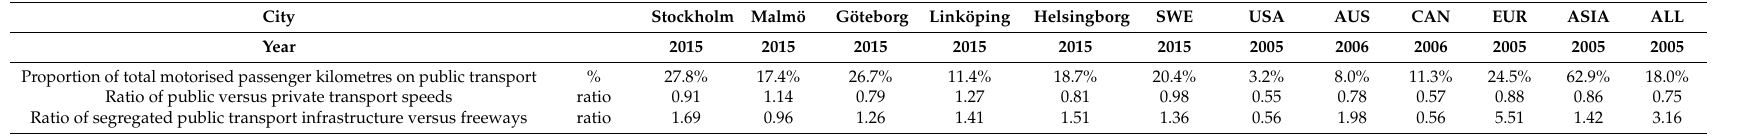
Table 8. Private–public transport balance indicators in Swedish and international